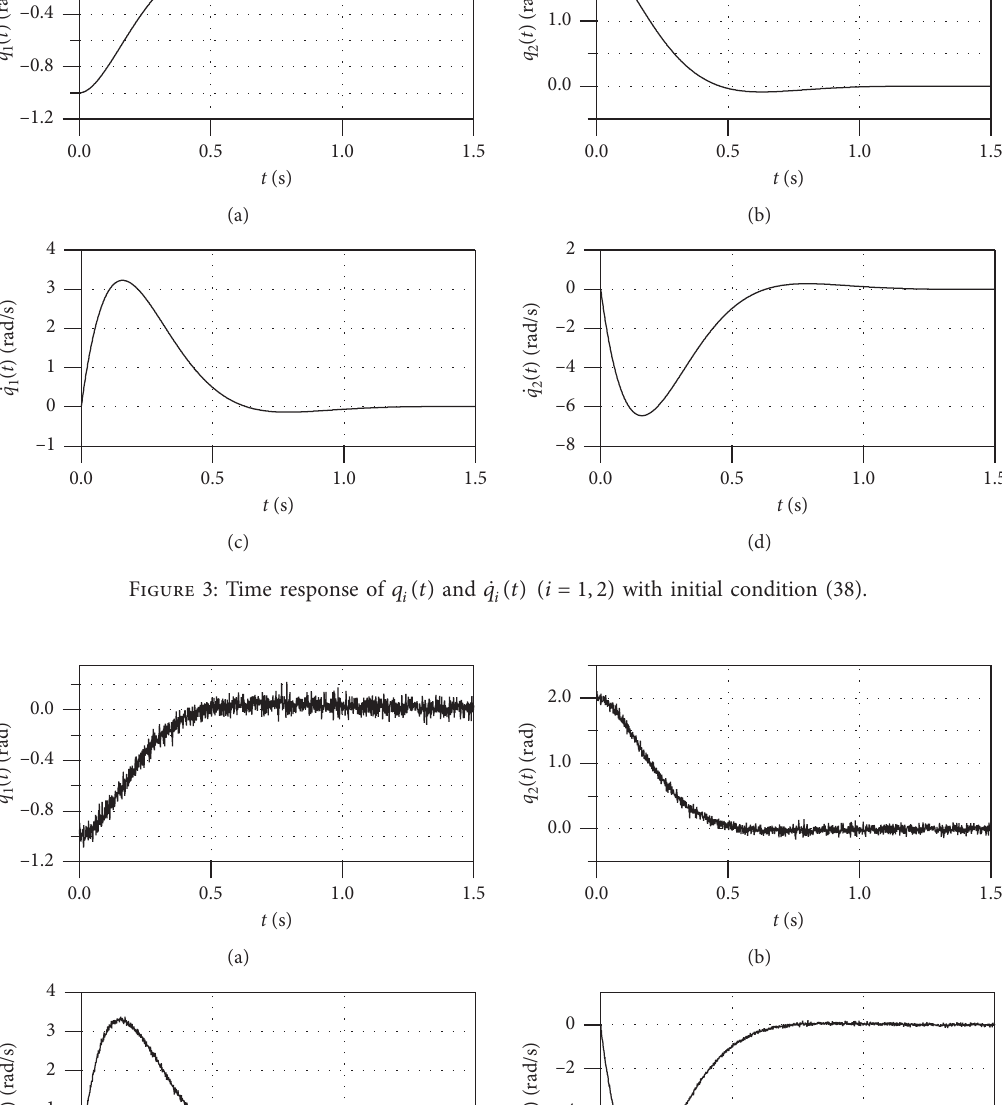
( t ) and _ q ( t ) ( i � 1 , 2 ) with initial condition (38) when parameter uncertainties, white noises, and friction i i